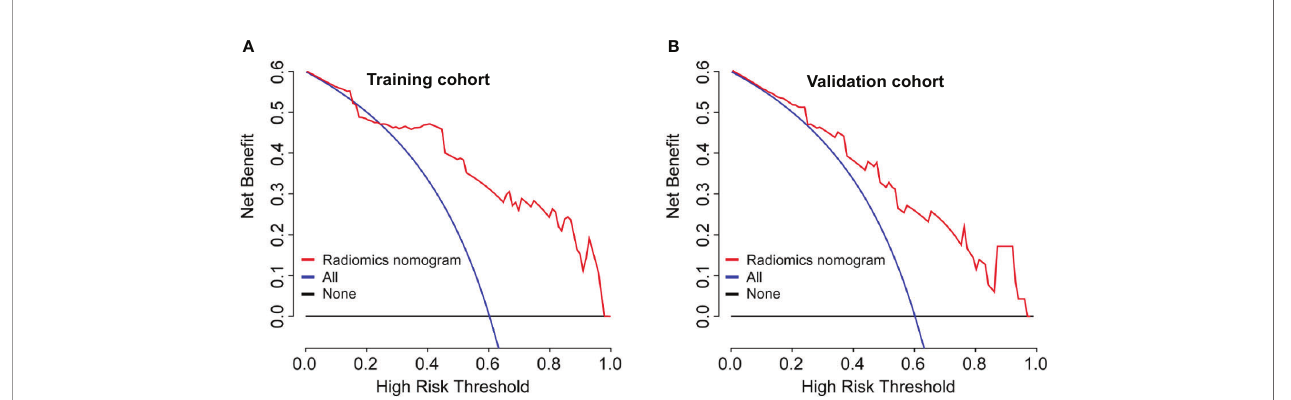
FIGURE 5 | Model comparisons and clinical usefulness of the radiomics nomogram. Decision curve analysis of the prediction nomogram model in the (A) training cohort and (B) validation cohort. The solid black line represents the net bene fi t when no breast cancer patients are thought to have relapse or death, while the solid blue line indicates the net bene fi t when all patients with breast cancer are thought to have relapse or death. The solid red line indicates the net bene fi t when all breast cancer patients are considered based on our newly constructed radiomics nomogram model. In this study, the decision curves show that the radiomics